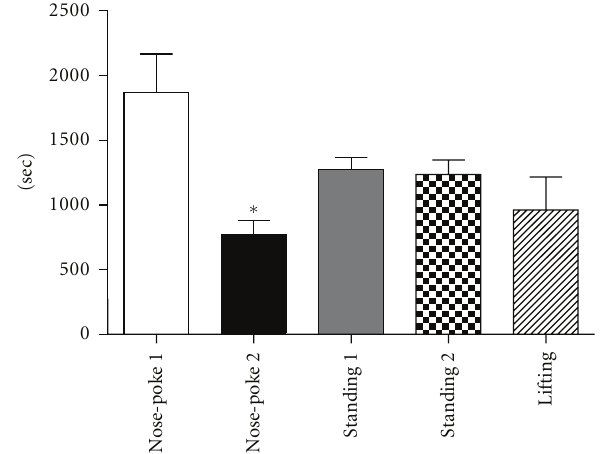
Figure 4: Time spent at each operant conditioning phase. Data are expressed as mean ± SEM. ∗ P < 0 . 05 versus nose-poke 1.